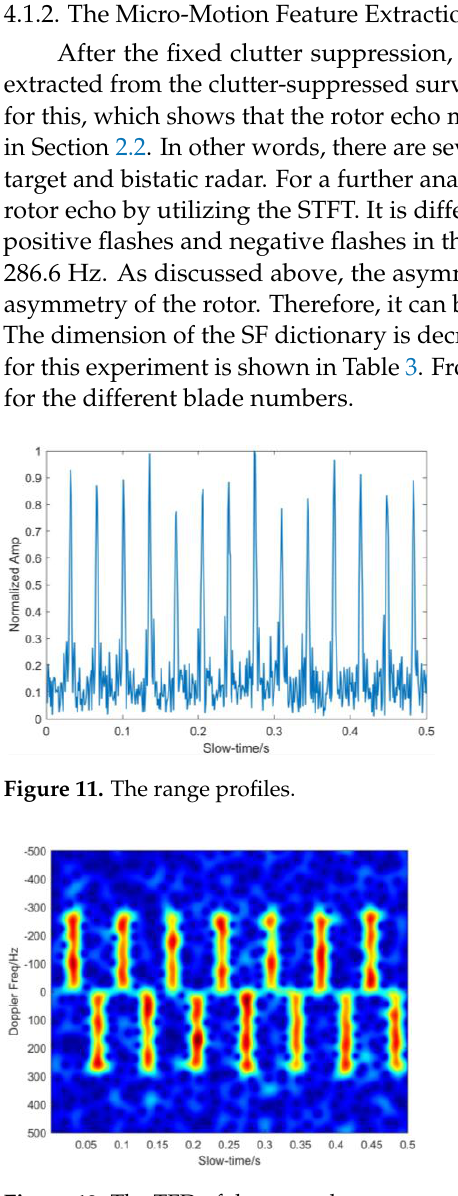
Figure 10. The CI after the ECA: ( a ) the range – amplitude plane; ( b ) the Doppler frequency – amplitude plane.